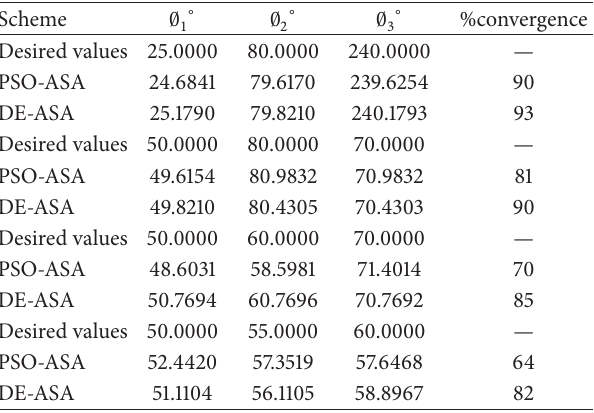
Table 7: Proximity effect of azimuth angles for 𝑠 1 = 1, 𝑠 2 = 3,𝑠 3 =